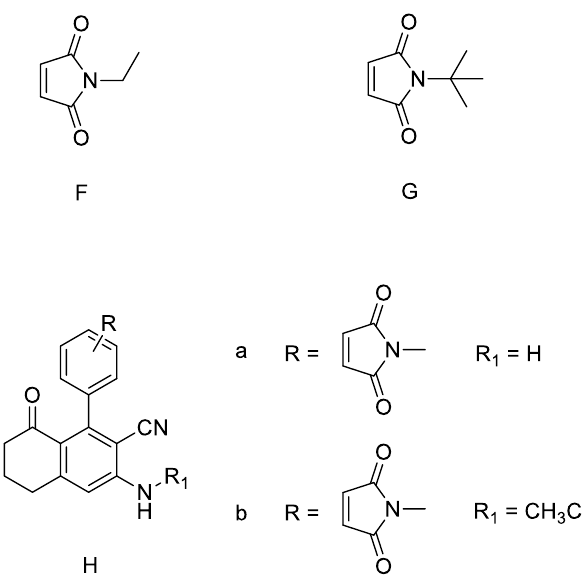
Figure 2. Structures of compounds with maleic amide fragment.